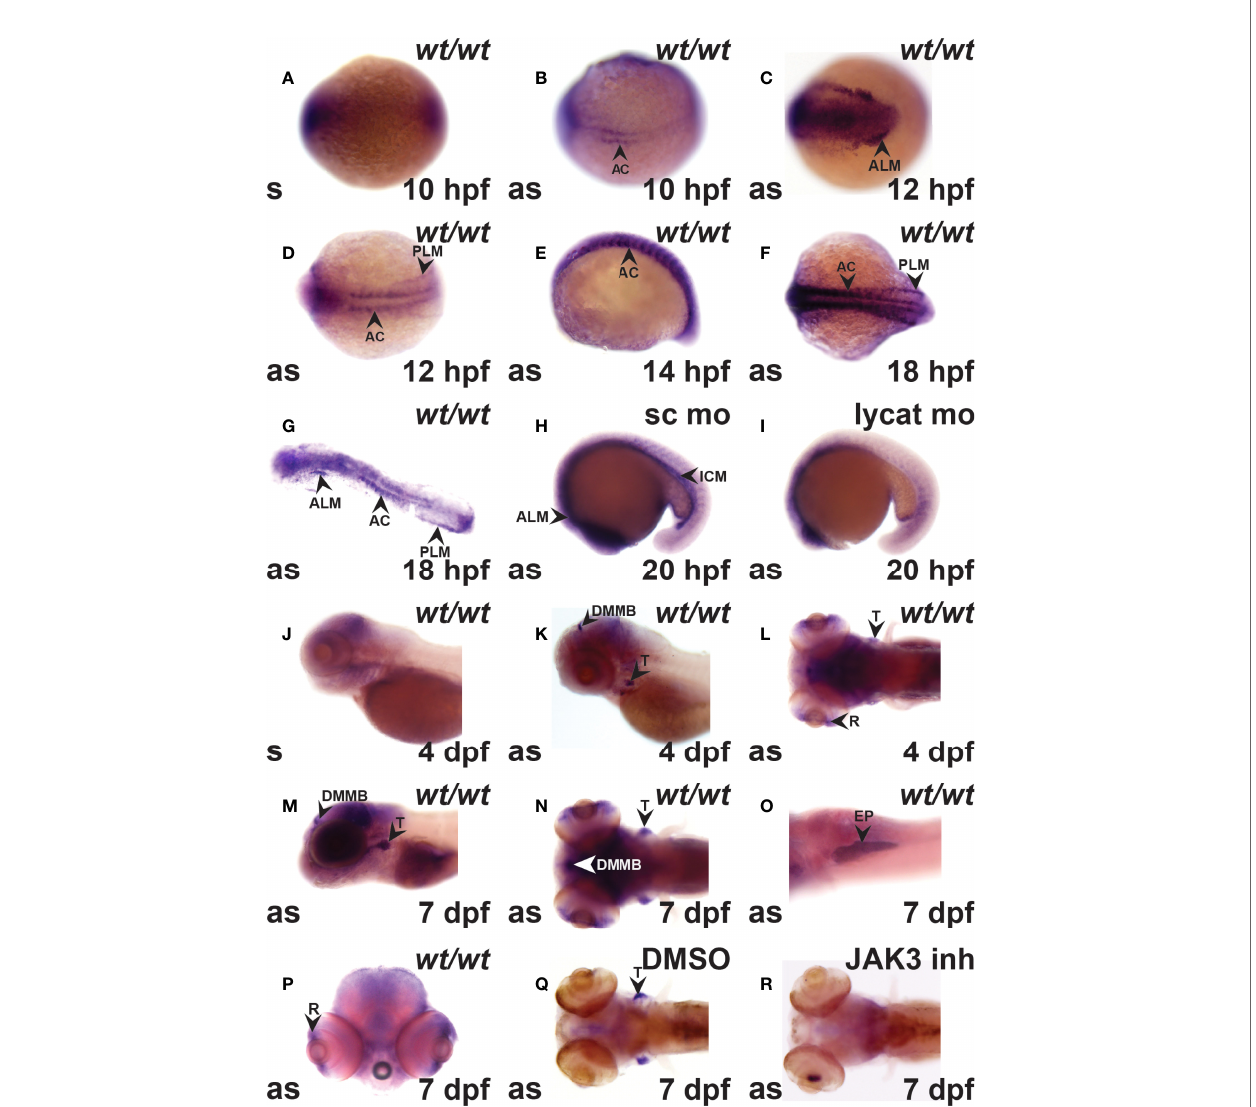
FIGURE 1 | The crlf3 gene is expressed in hematopoietic and other tissues during zebra fi sh embryogenesis. (A – R) . WISH with sense (s) or antisense (as) crlf3 probes at the indicated time points on wild-type embryos ( wt/wt , A – G, J – P ) or those injected with 1 mM standard control morpholino (sc mo, H ) or lycat morpholino (lycat mo, I ) or bathed from 56 hpf in DMSO vehicle control (DMSO, Q ) or JAK3 inhibitor (JAK3 inh, R ). Embryos are dorsal view with anterior to the left (A, B, D, F, L, N, Q, R) ; anterior view with dorsal to the left (C) ; lateral view with anterior to the left (E, J, K, M) , except panel O that is ventral view with anterior to the left and P is anterior view with dorsal to the top. The indicated structures are: AC (adaxial cells), ALM (anterior lateral plate mesoderm), DMMB (dorsal midline of midbrain), EP (exocrine pancreas), ICM (intermediate cell mass), PLM (posterior lateral plate mesoderm), R (retina), and T